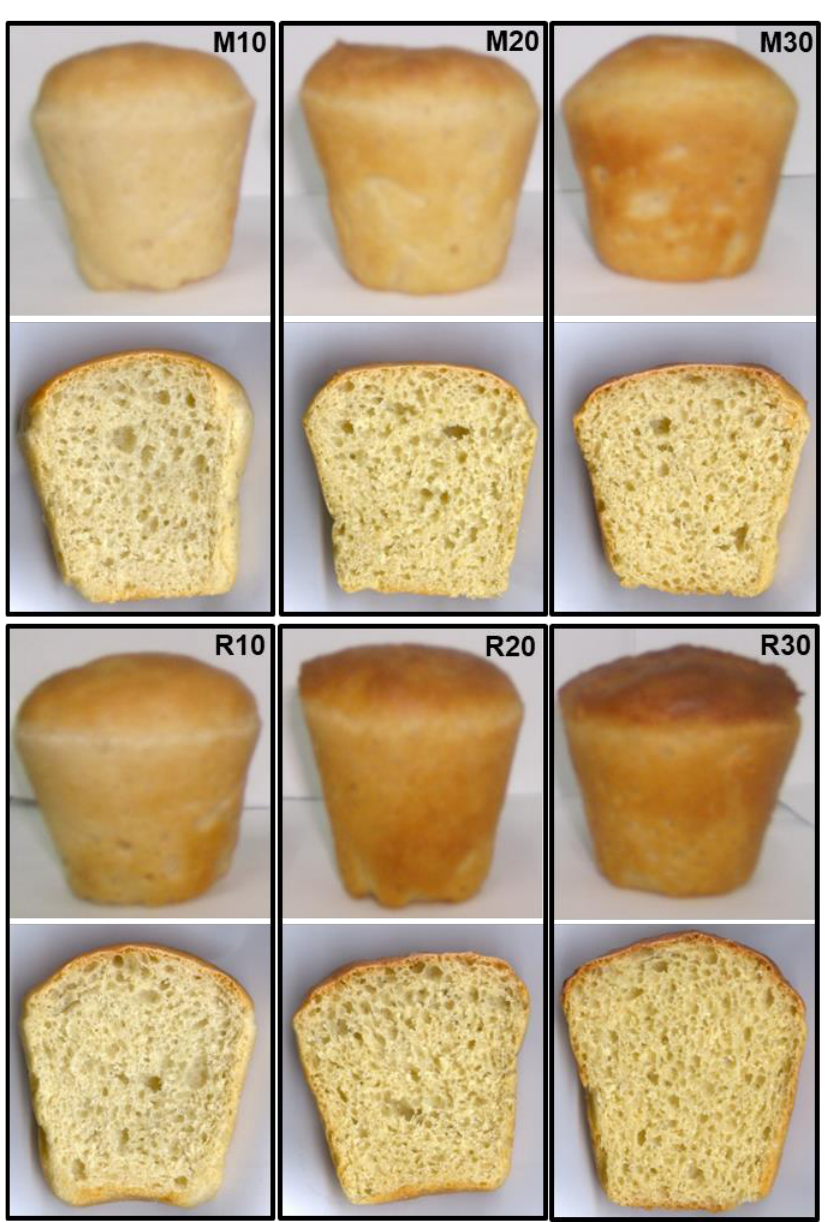
Figure 4. Slices of wheat-bread with incorporations of Rumbo flour (R10, R20 and R30) and Misak flour (M10, M20 and M30).